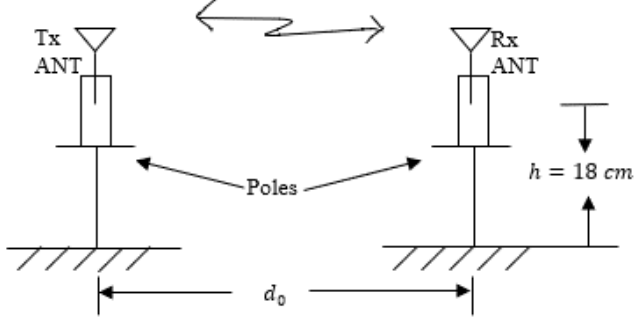
Figure 4. Transceivers attached to the